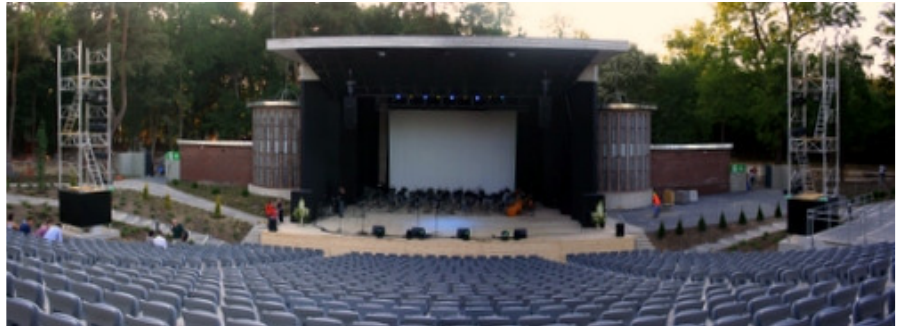
Figure 15. Renovated Open-air theatre. Source: own collection.